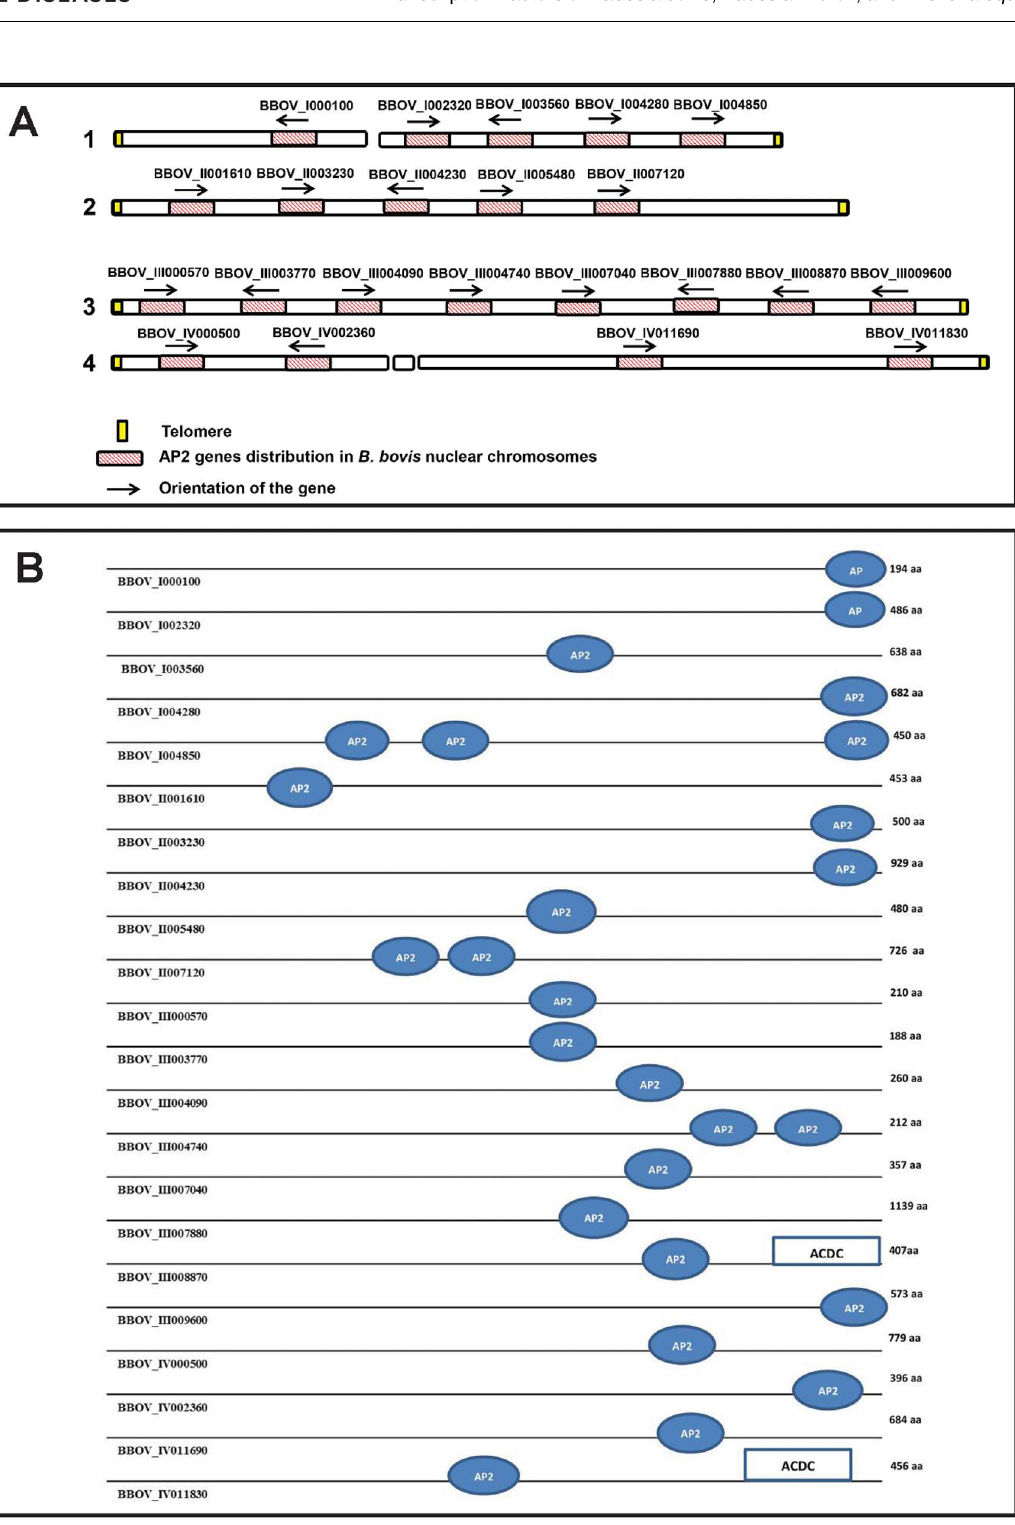
Fig 1. Schematic representation of the location of the 22 AP2 genes and the number and domains identified in the genome of B . bovis (data not presented to scale). (A) The figure represents the genomelocalizationof the B . bovis AP2 genes, distributed among the four chromosomes. Each gene orientationis indicated by black arrows. (B) Gene nomenclature, schematic representation of the number and location of the AP2 domains of the B . bovis AP2 proteins. The presence and location of the ACDC domains in the protein are also